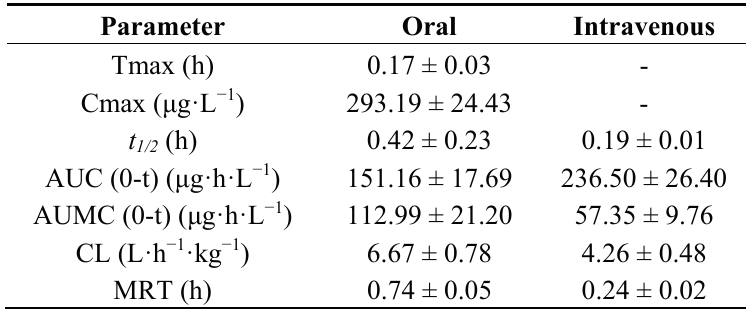
Table 3. Pharmacokinetic parameters of triptolide in rats after oral or intravenous